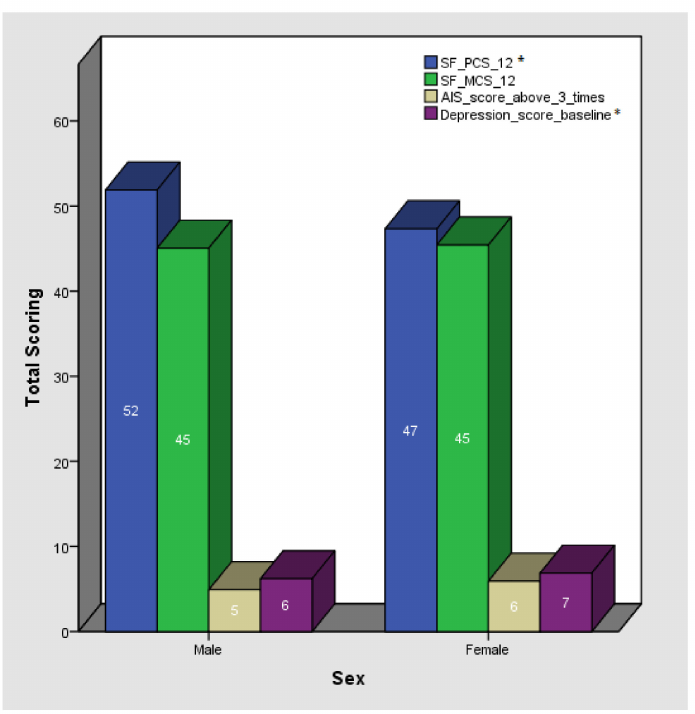
Figure 3. Baseline scoring of the four lifestyle questionnaires, based on sex (* The presented variables were statistically significantly different between the